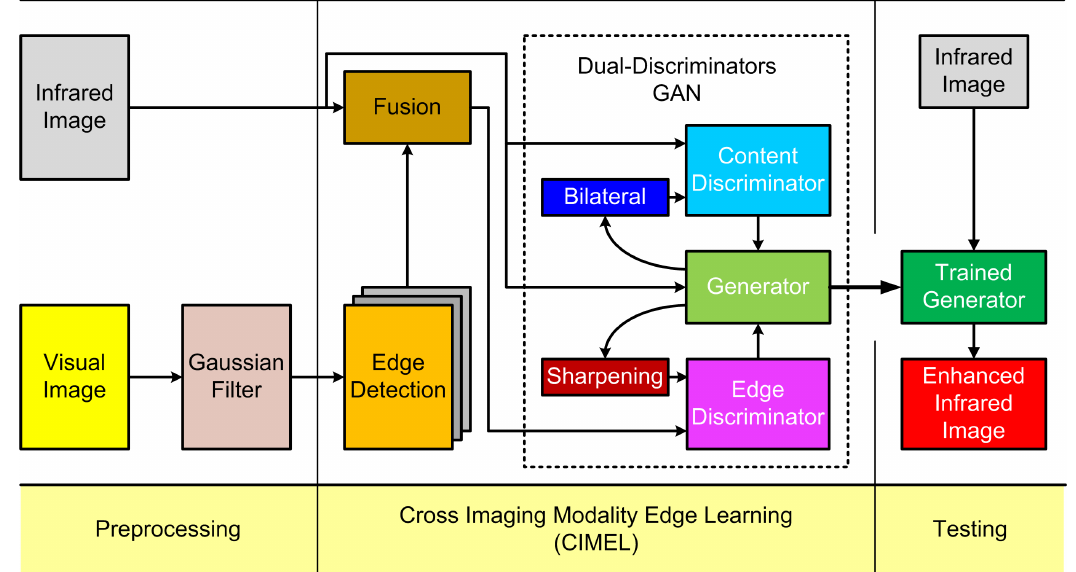
Figure 1. The proposed CIMEL framework to enhance edges in IR images by acquiring knowledge from images in the visible